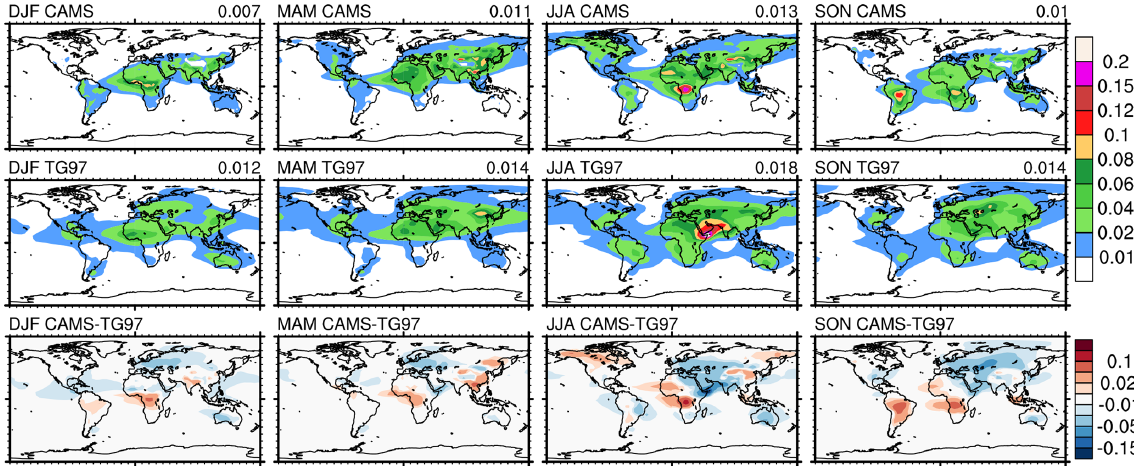
Figure 5. As Fig. 4 but for absorption optical